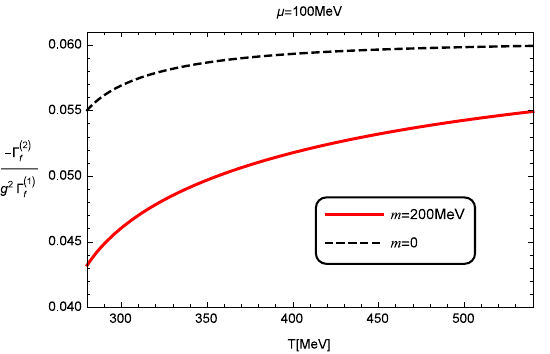
Figure 5 . The ratio between one- and two-loop fermionic e(cid:11)ective potential as a function of temperature T . Two di(cid:11)erent quark masses m = 0 and m = 200MeV are considered. In this plot, N f = 1 and the quark chemical potential (cid:22) = 100MeV. The temperature dependence of the background (cid:12)eld is determined based on matrix